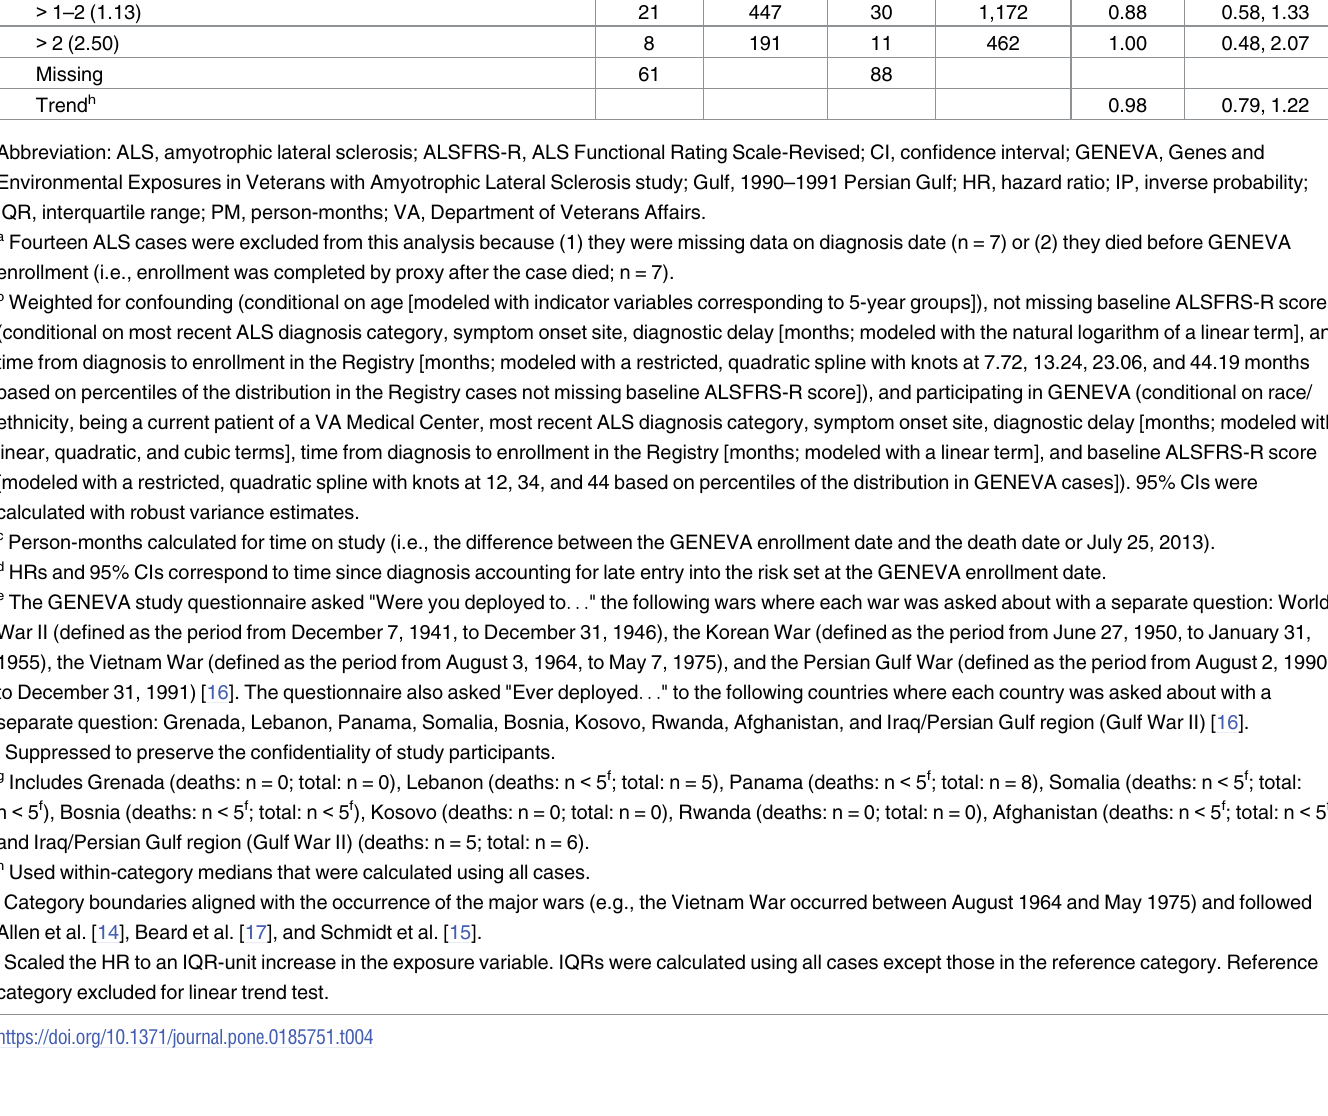
(Table H in S1 File), control confounding by sex, or mitigate potential bias from exposure mis- classification. Using age as the timescale, with late entry at GENEVA enrollment date, pro- duced similar results. Recoding implausible values to missing for exposures that had distinct time periods of use removed the association between anthrax vaccination and shorter survival (HR = 0.99; 95% CI: 0.43, 2.26), but gave qualitatively similar results for the other three expo- sures. The majority of exposures were either not or only weakly correlated (absolute value of coefficients (cid:20) 0.2), and results were similar after mutually-adjusting correlated exposures. Finally, adjusting for potential confounding via standard regression methods, but